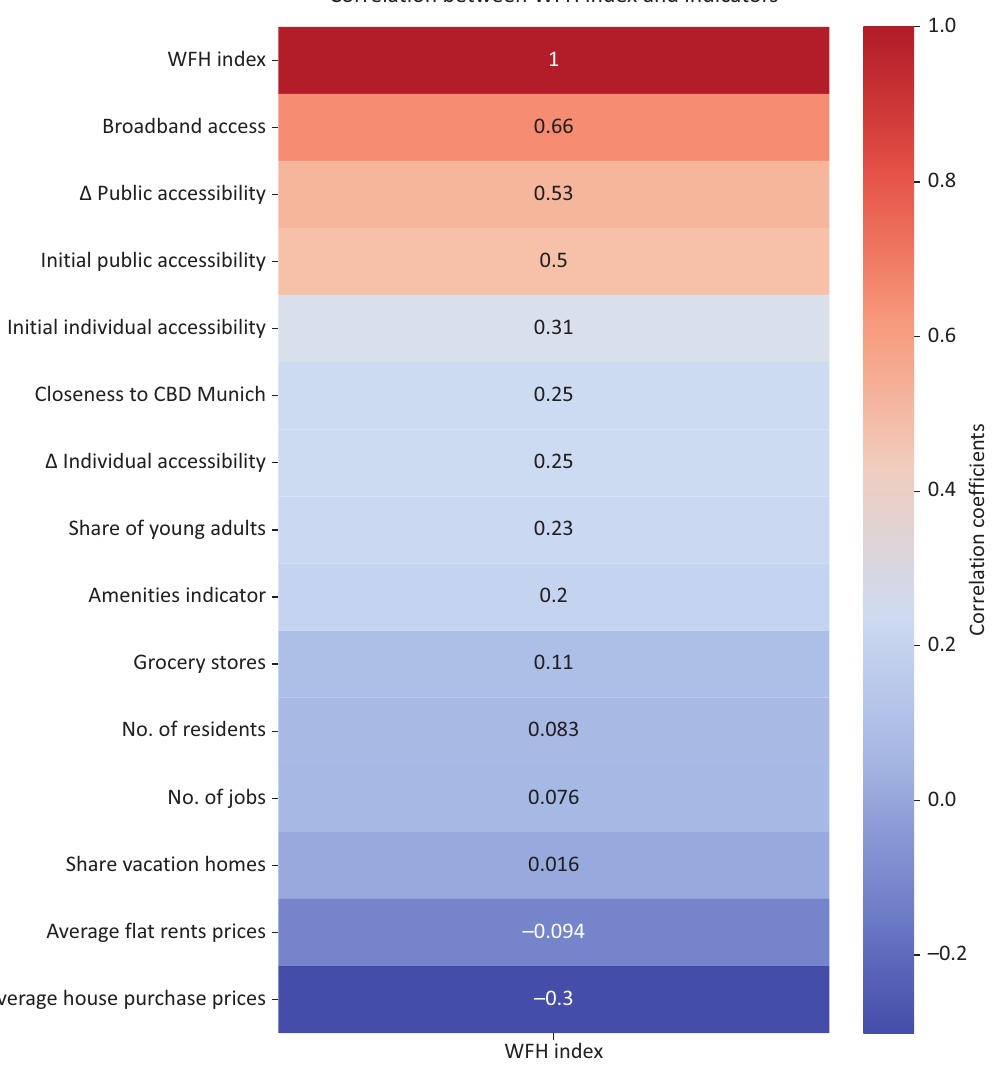
Figure 4. Correlations between WFH index and sub‐indicators in the